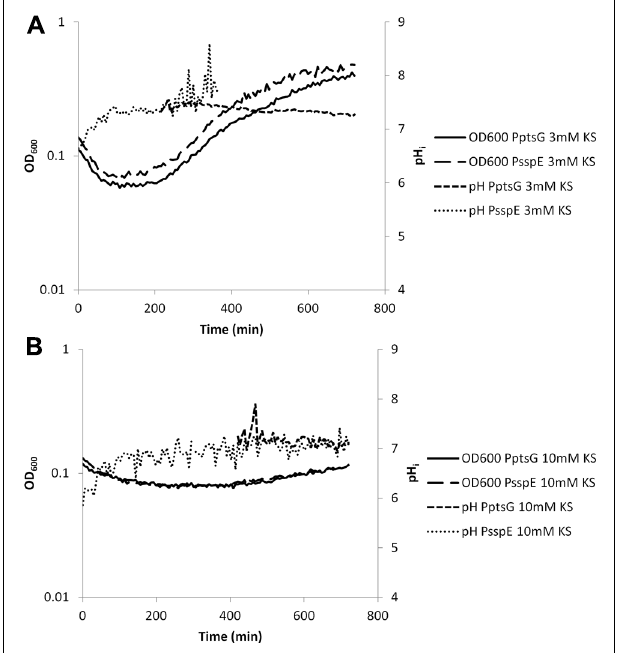
FIGURE 6 | Internal pH during spore germination and outgrowth. IpHluorin accumulated in the spores (from expression controlled by P sspE ) allows pH measurements from t = 0 to approximately 300 min. Expression of IpHluorin from P ptsG allows calculation of the pHi from approximately 200 min. Data are from a representative example. (A) Germination and outgrowth of B. subtilis spores at an external pH = 6.4 with 3 mM KS. (B) Germination and outgrowth of B. subtilis spores at an external pH = 6.4 with 10 mM